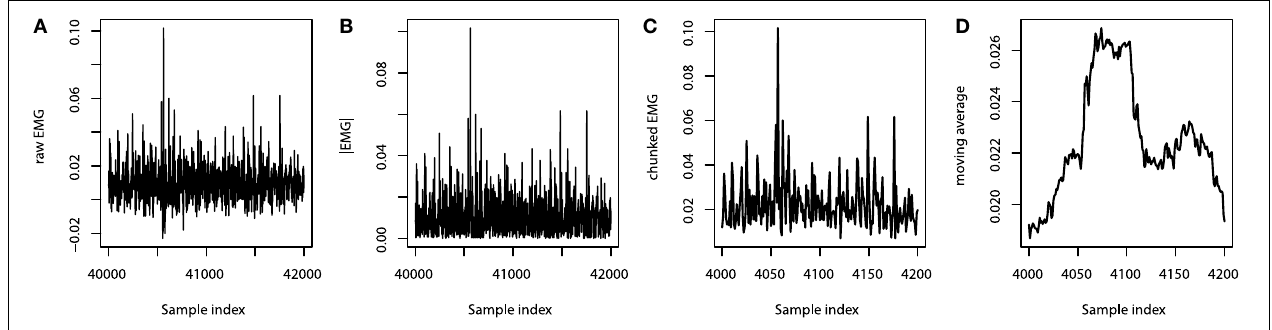
FIGURE 6 | EMG processing: (A) raw EMG data; (B) absolute EMG sensor values; (C) chunked EMG data; (D) moving average smoothed